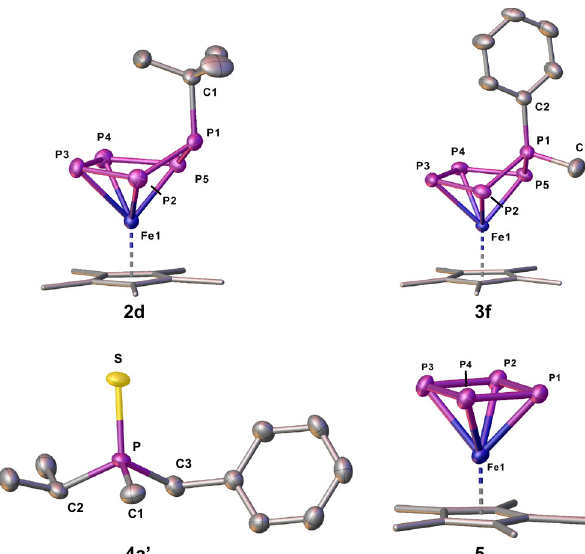
Fig. 3 Molecular structures of the anions in 2d, 5 and of the neutral complexes 3f, 4a ′ with thermal ellipsoids at 50% probability level. Cations and hydrogen atoms are omitted for clarity. The Cp* ligands are drawn in the wire frame model.